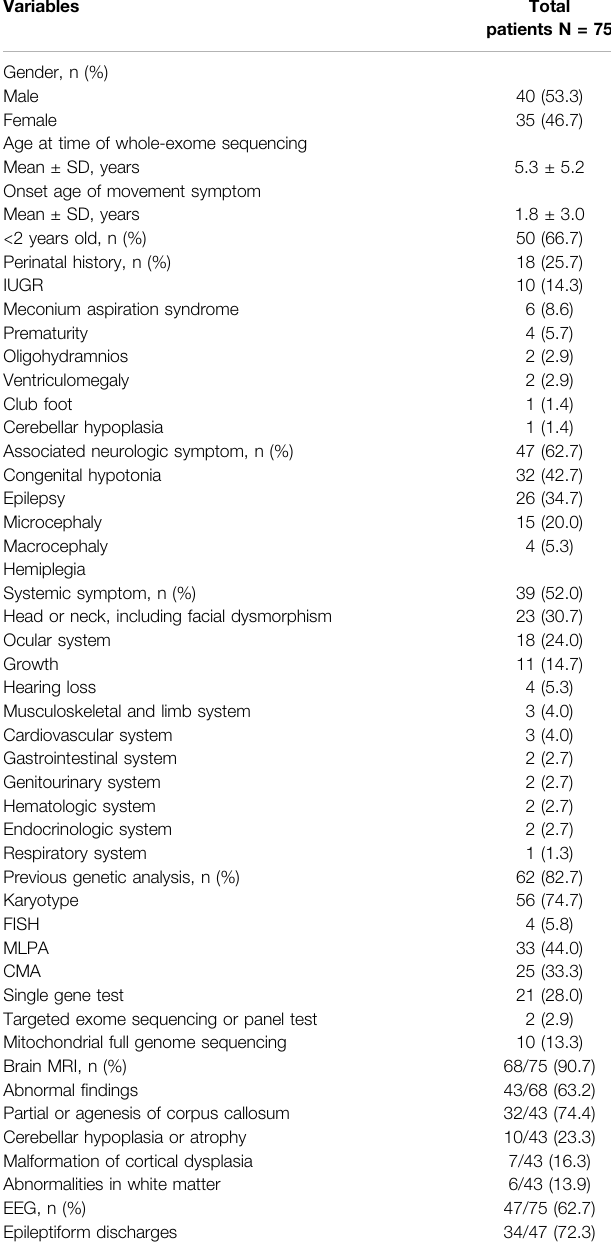
TABLE 1 | Clinical characteristics of patients with movement disorders. Variables Total